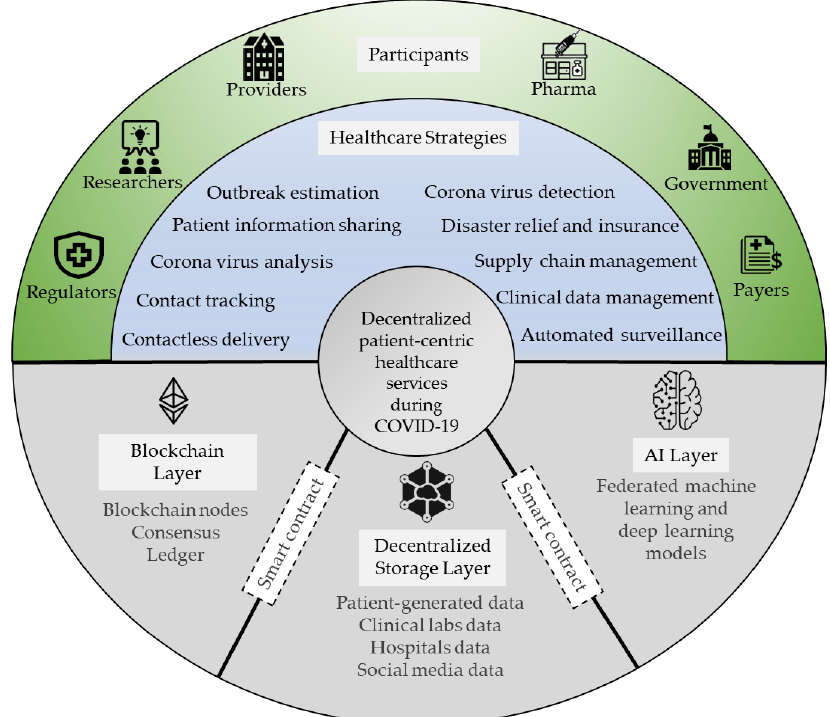
Figure 4. The convergence of blockchain and AI for a decentralized, patient-centric healthcare system to tackle COVID-19.